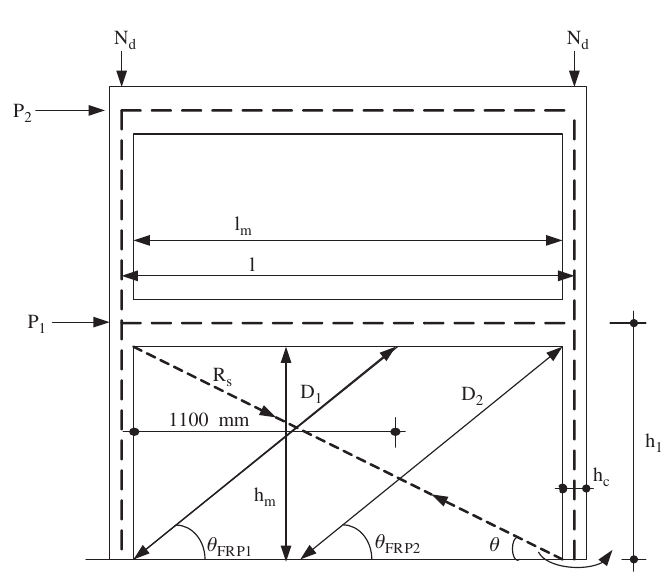
Figure 18 Forces acting on the specimen